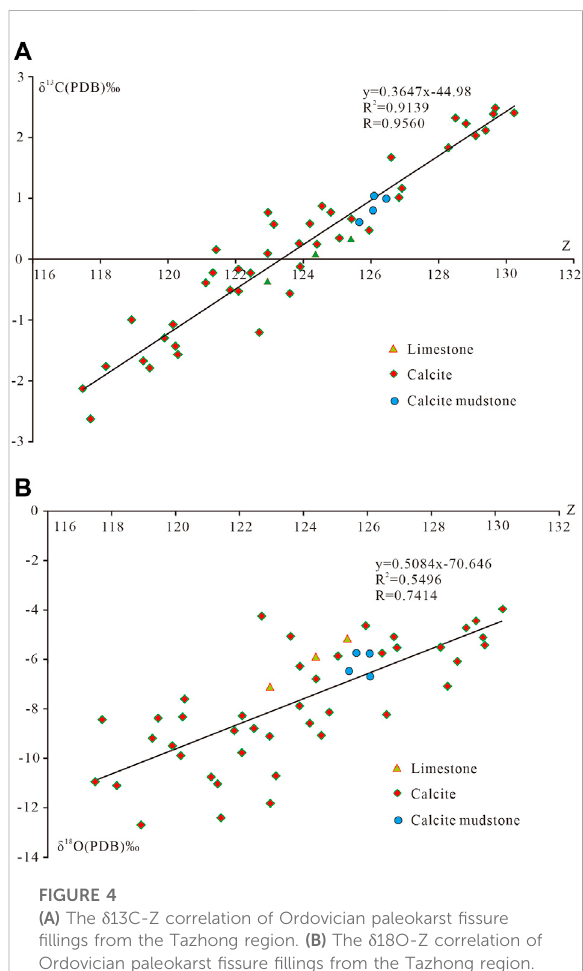
FIGURE 4 (A) The δ 13C-Z correlation of Ordovician paleokarst fi ssure fi llings from the Tazhong region. (B) The δ 18O-Z correlation of Ordovician paleokarst fi ssure fi llings from the Tazhong